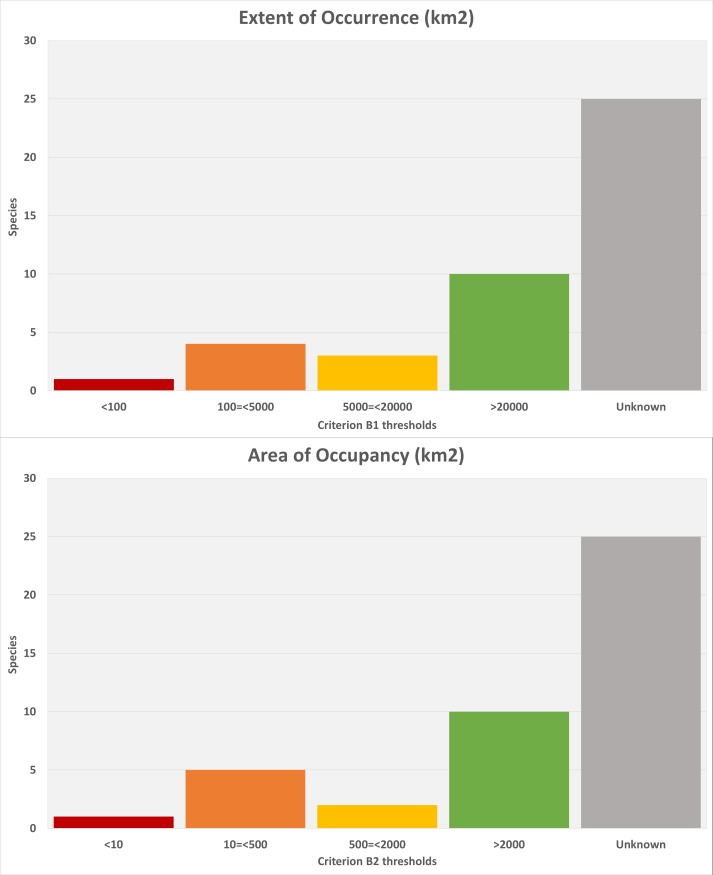
Extent of Occurrence (EOO) and Area of Occupancy (AOO) amongt all species.